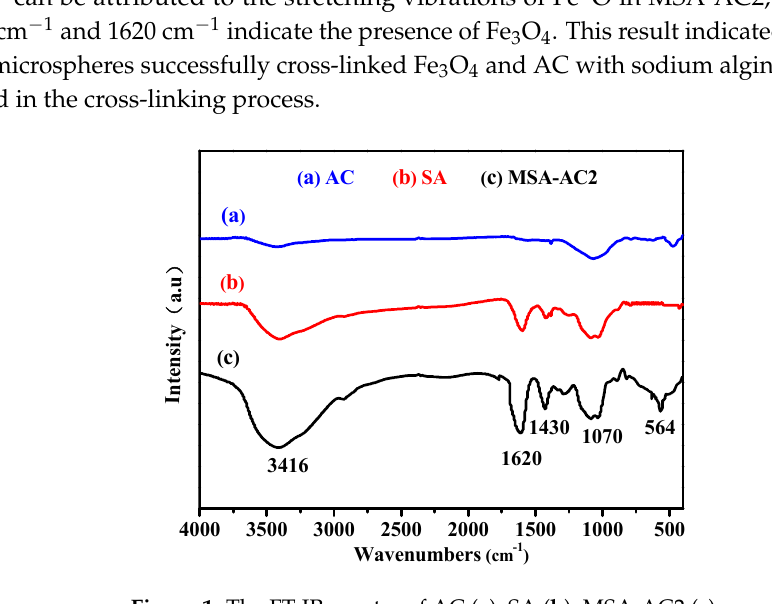
Figure 1. The FT-IR spectra of AC ( a ); SA ( b ); MSA-AC2 ( c ).